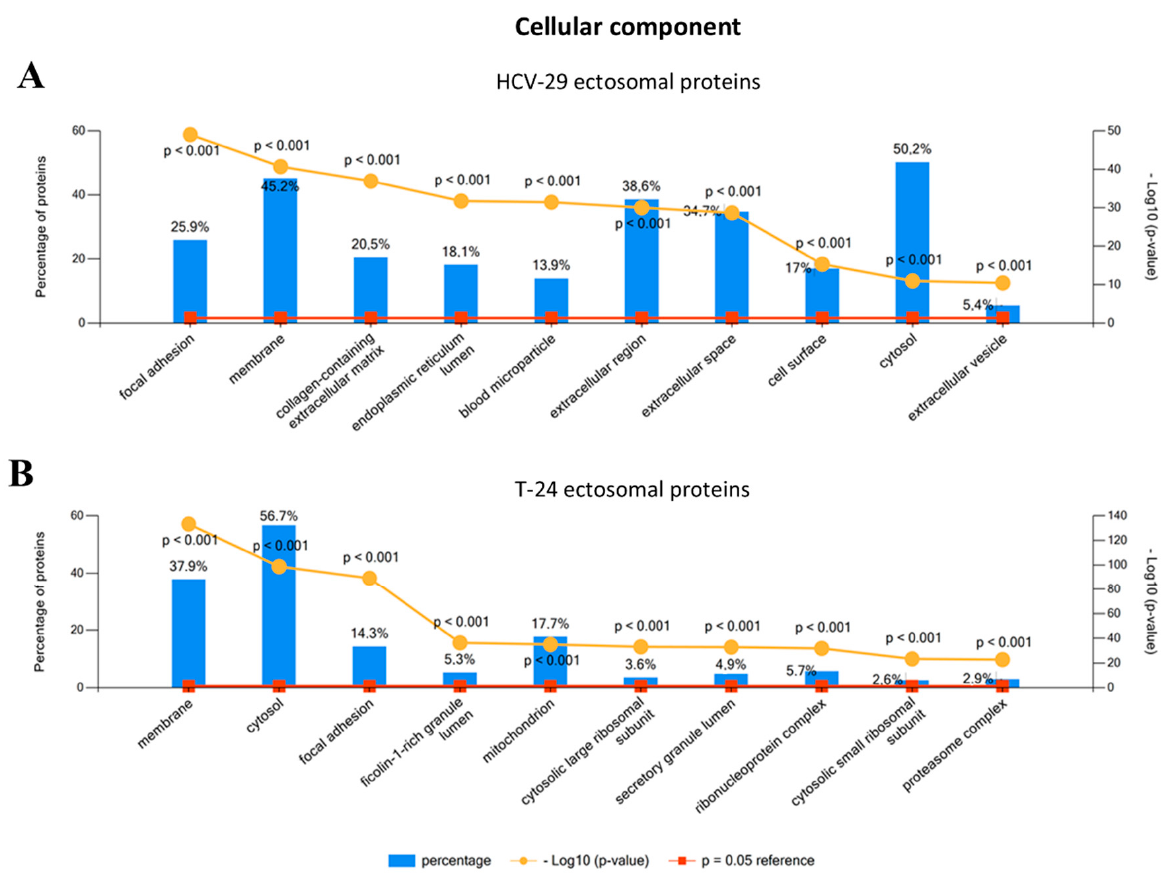
Figure 3. Gene ontology (GO) analysis of proteins identified in ectosomes derived from HCV-29 normal ureter epithelial cells ( A ) and T-24 urothelial bladder carcinoma cells ( B ) performed with the use of FunRich 2.0 software with UniProt (release 2020_12) database as a reference. For GO term “Cellular compartment” ten categories with the highest statistical significance of protein enrichment within the specific category ( p < 0.001) were presented on graphs. Complete results of GO analysis are provided in Supplementary Data S2.